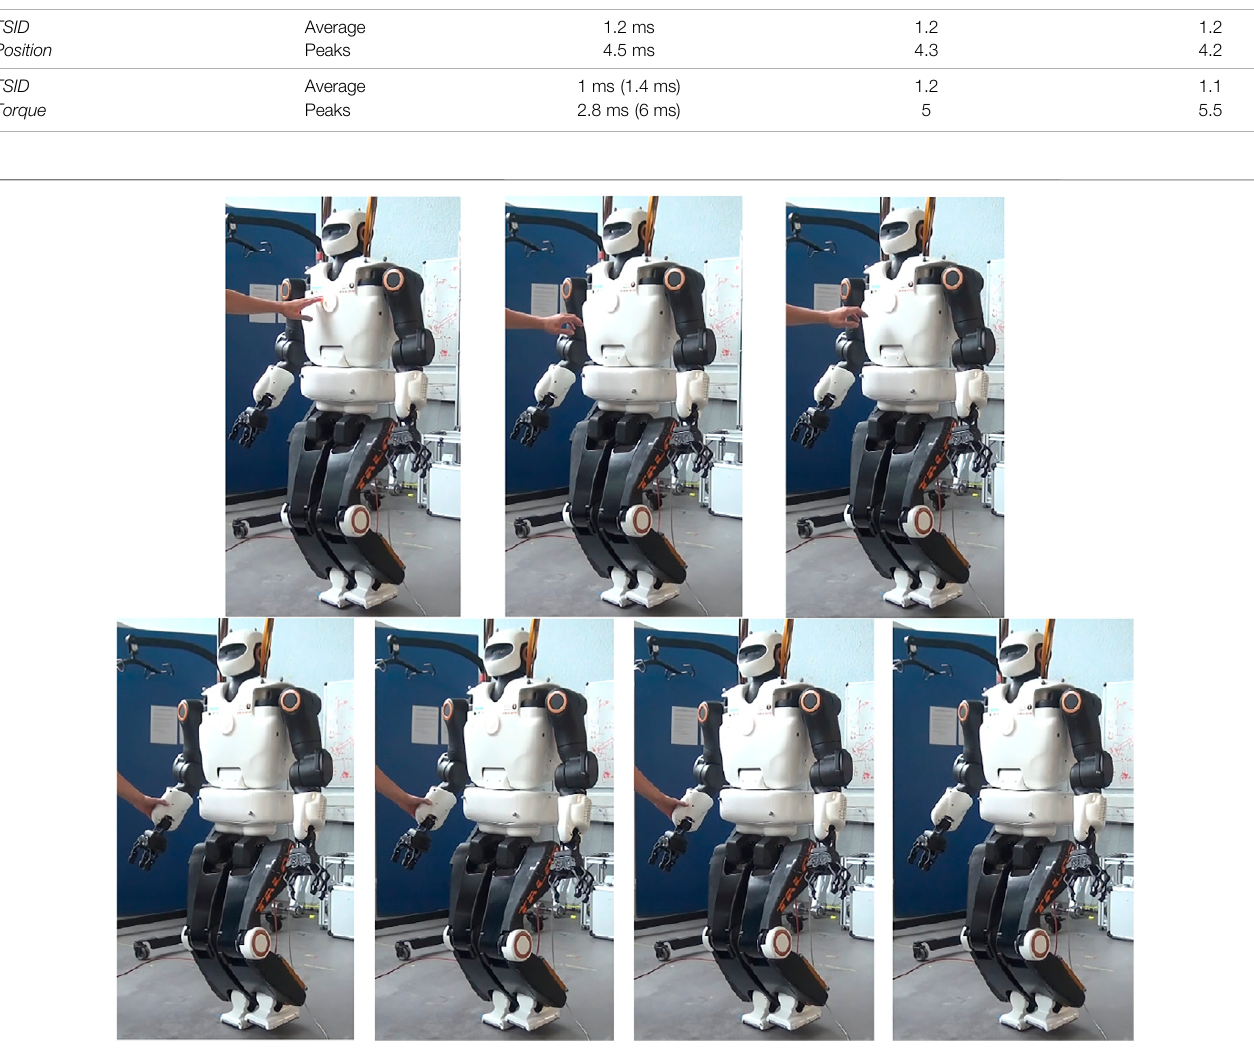
FIGURE 10 | Experiments — push recovery of the TALOS robot with one foot raised.